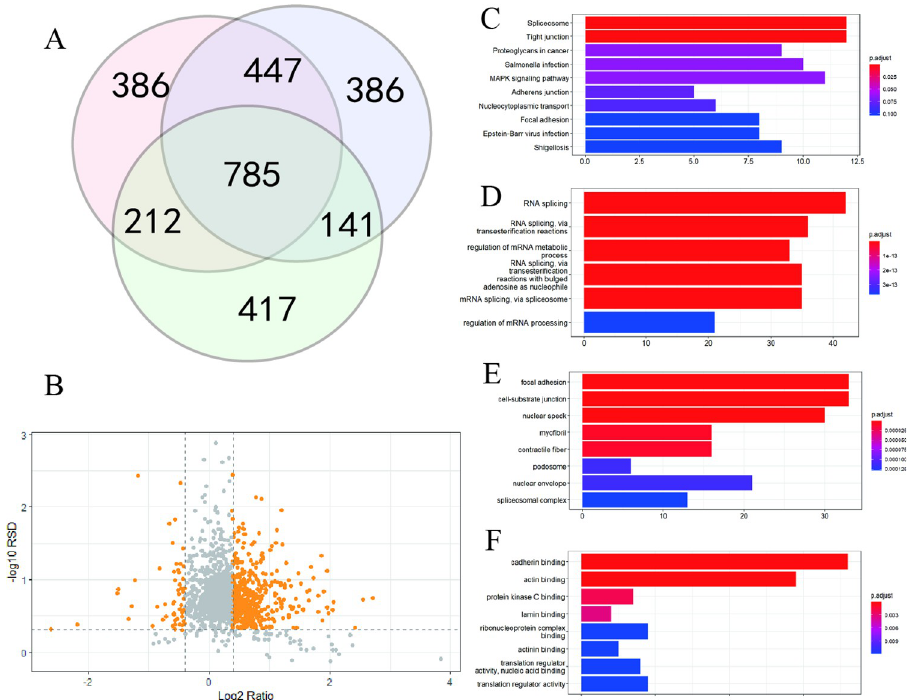
Fig 4. Phosphoproteomic analysis when BEAS-2B treated with silica. (A) Venn diagram of the quantified phosphorylation sites. (B) Volcano graph. Significant phosphorylation sites are presented in color. (C) KEGG enrichment of differentially phosphorylated proteins. (D-F) GO analysis of differentially phosphorylated proteins, including biological function (D), cellular component (E), and molecular function (F).